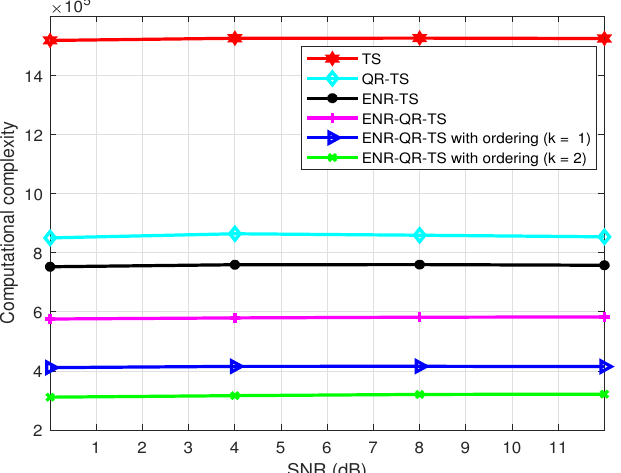
Figure 4. Comparison of the computational complexity of TS algorithms for a 16 × 16 MIMO system with